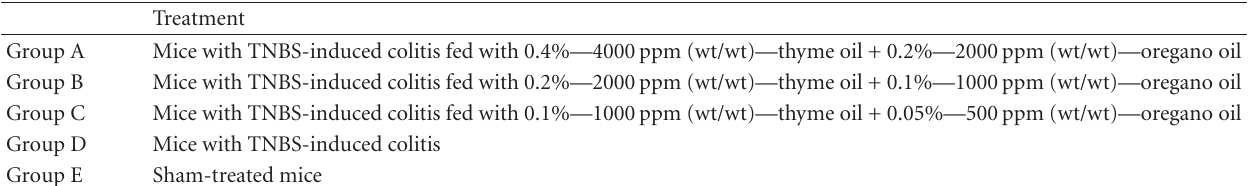
Table 1: Experimental groups of